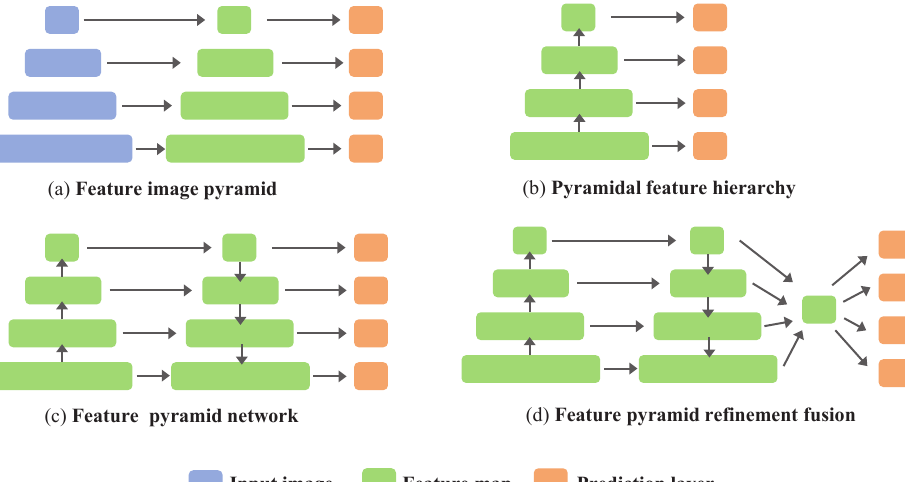
Figure 4. ( a ) Using an image pyramid to build a feature pyramid, which is an inefficient method [41]. ( b ) Reusing the pyramidal feature hierarchy computed by a ConvNet as if it were a featurized image pyramid, as with a single-shot multi-box detector (SSD) [15]. ( c ) Bottom-up and top-down pathway feature fusion, as in an FPN [19]. ( d ) Our proposed feature pyramid refinement